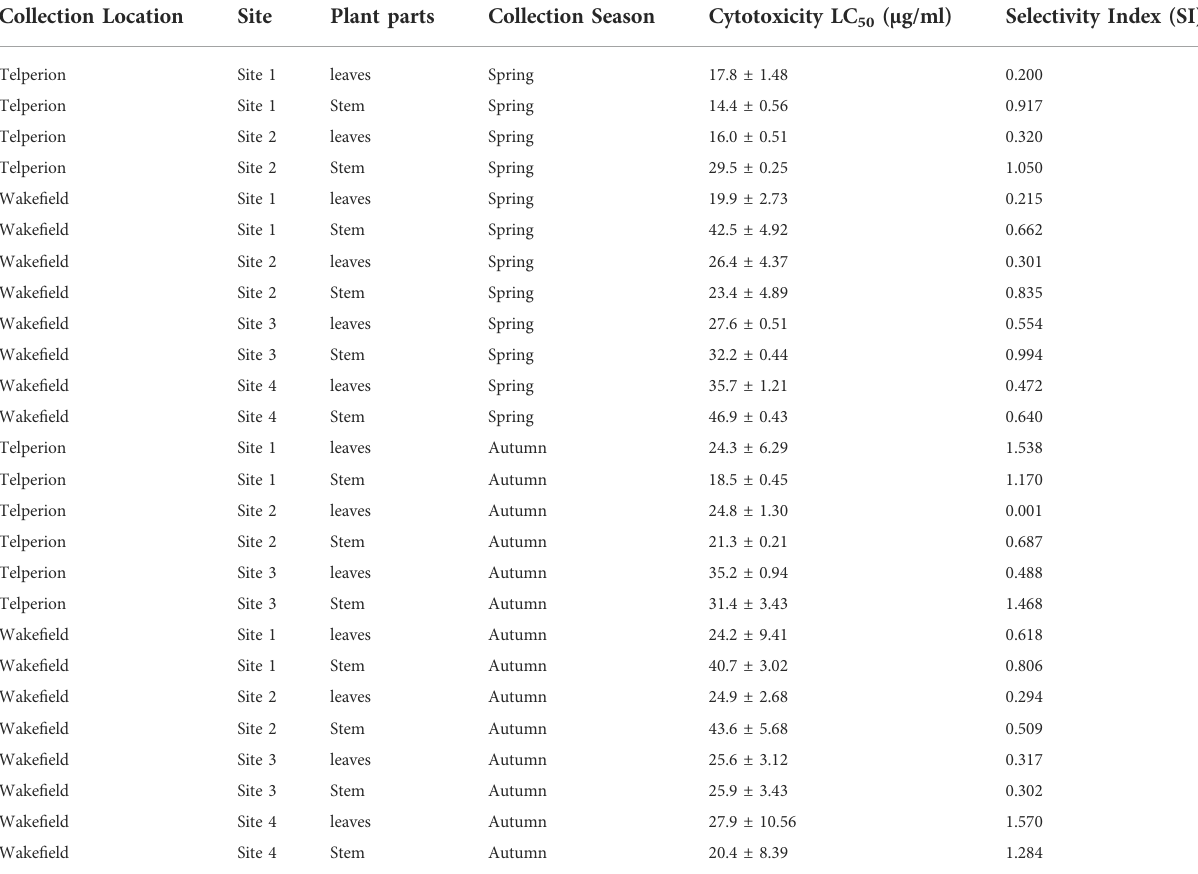
TABLE2Cytotoxiceffectsofleavesandstemextractsof H.aureonitens atdifferentsitesattwodiversegeographicallocationsandtwoseasonsofthe